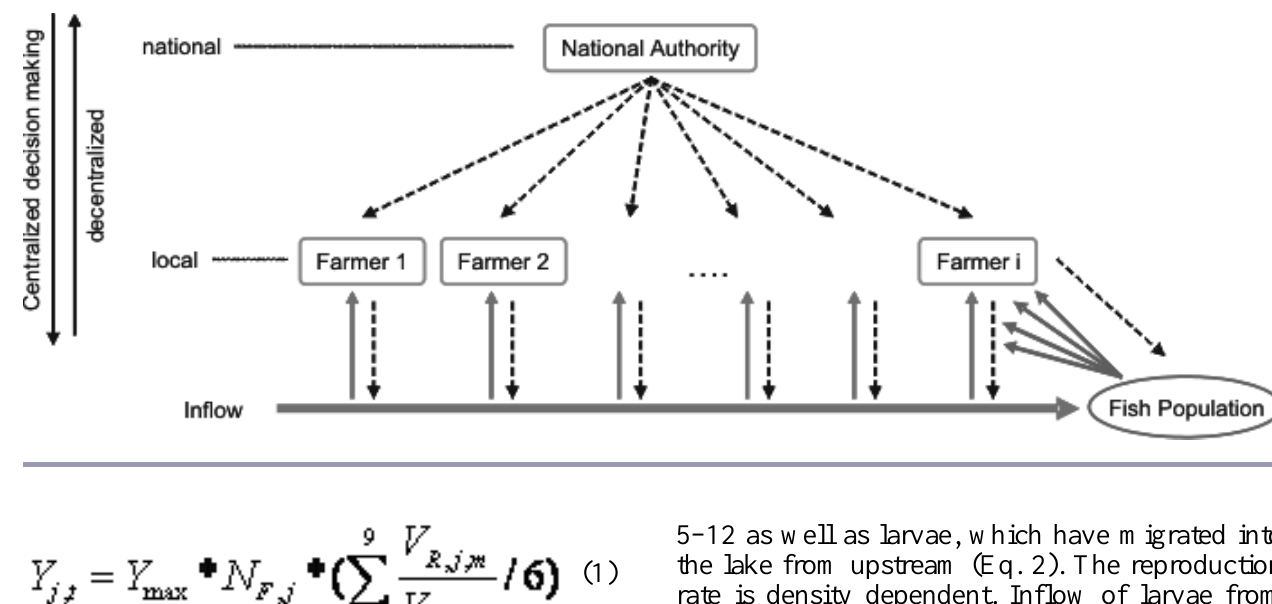
Fig. 3. The general structure of the model, which is then modified for each specific model implementation, e.g., the centralized and the decentralized models presented here. Agents take water allocation decisions at both global and local levels. Farmers extract water resources for irrigation sequentially according to their location along the river. All farmers can additionally access fish resources in the lake, however downstream farmers can access them prior to upstream